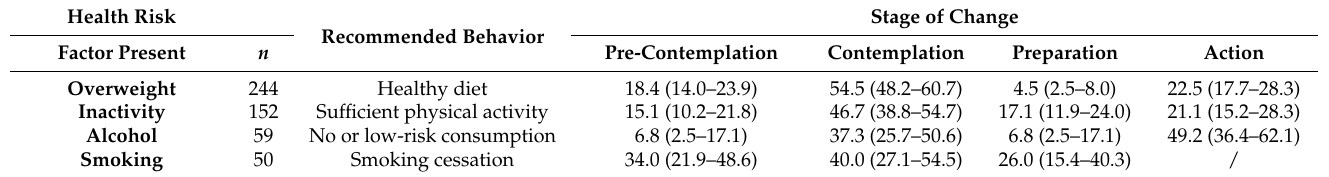
Table 5. Stages of change regarding recommended health behaviors for participants with the respec- tive behavioral health risk factor (percent, 95% confidence